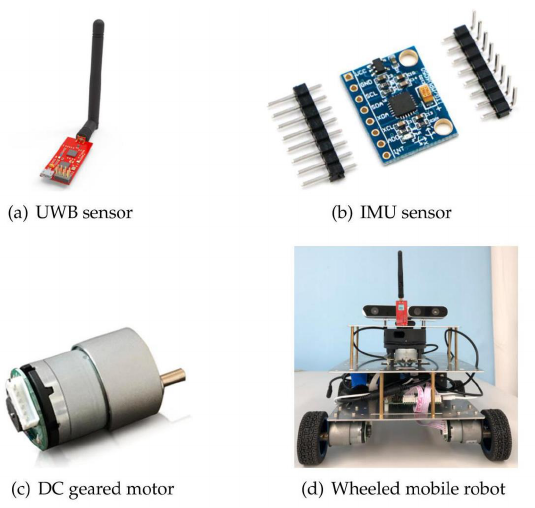
Figure 3. The sensors and the mobile robot involved in this article: ( a ) The Ultra-Wide Band (UWB) sensors (YCHIOT, Wenzhou, Zhejiang, China), which are commercial products provided by the company of YCHIOT, with the module of Mini3s; ( b ) the spatial motion sensor chip MPU9150 as the IMU sensor (Digi-Key Electronics, Thief River Falls, Minnesota, United States); ( c ) the odometer84 constructed by the DC gear motors MG513 with an encoder (Fenghua Transmission, Kunshan, Jiangsu, China); and ( d ) the wheeled mobile robot platform (Ruiqu Technology, Foshan, Guangdong, China) that realizes the precise localization by carrying the above